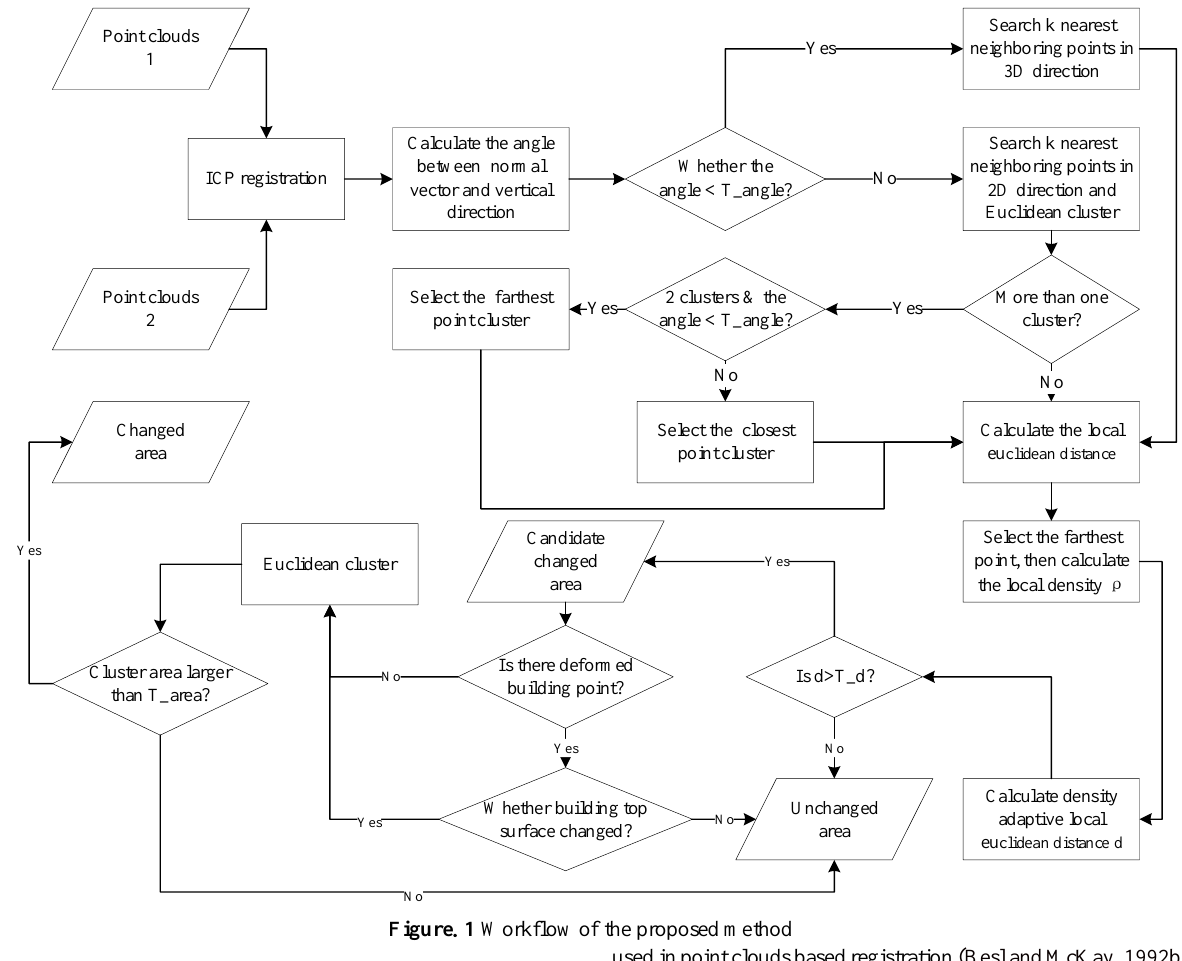
Figure . 1 Workflow of the proposed